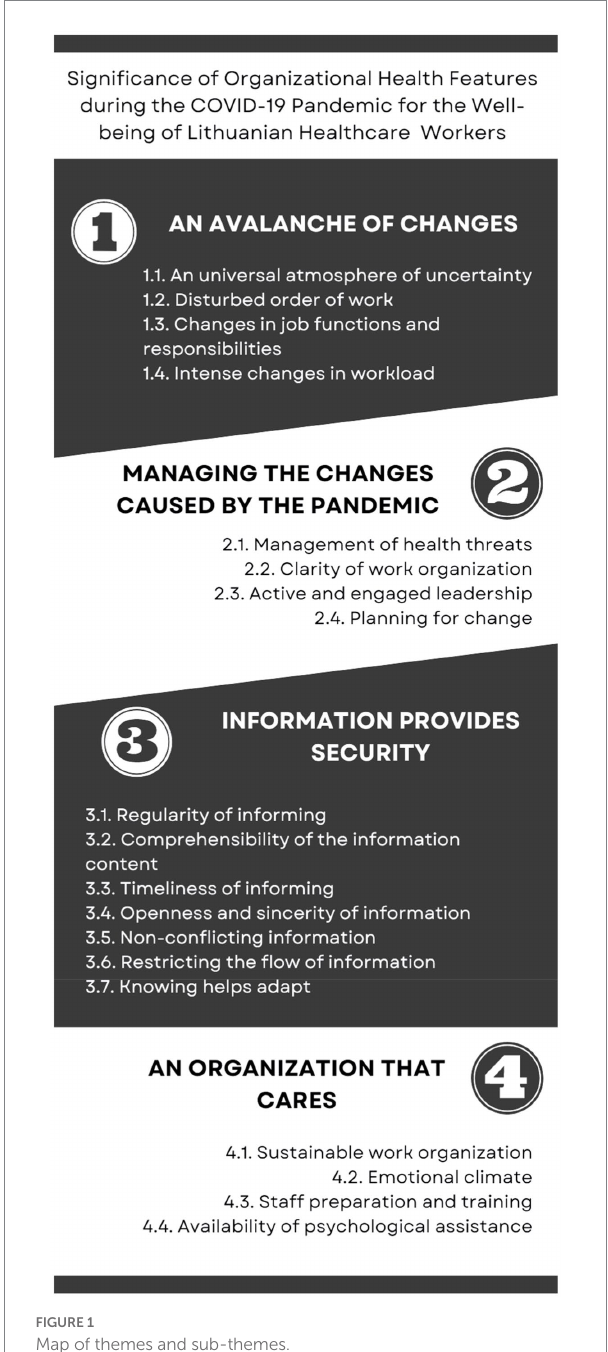
FIGURE 1 Map of themes and